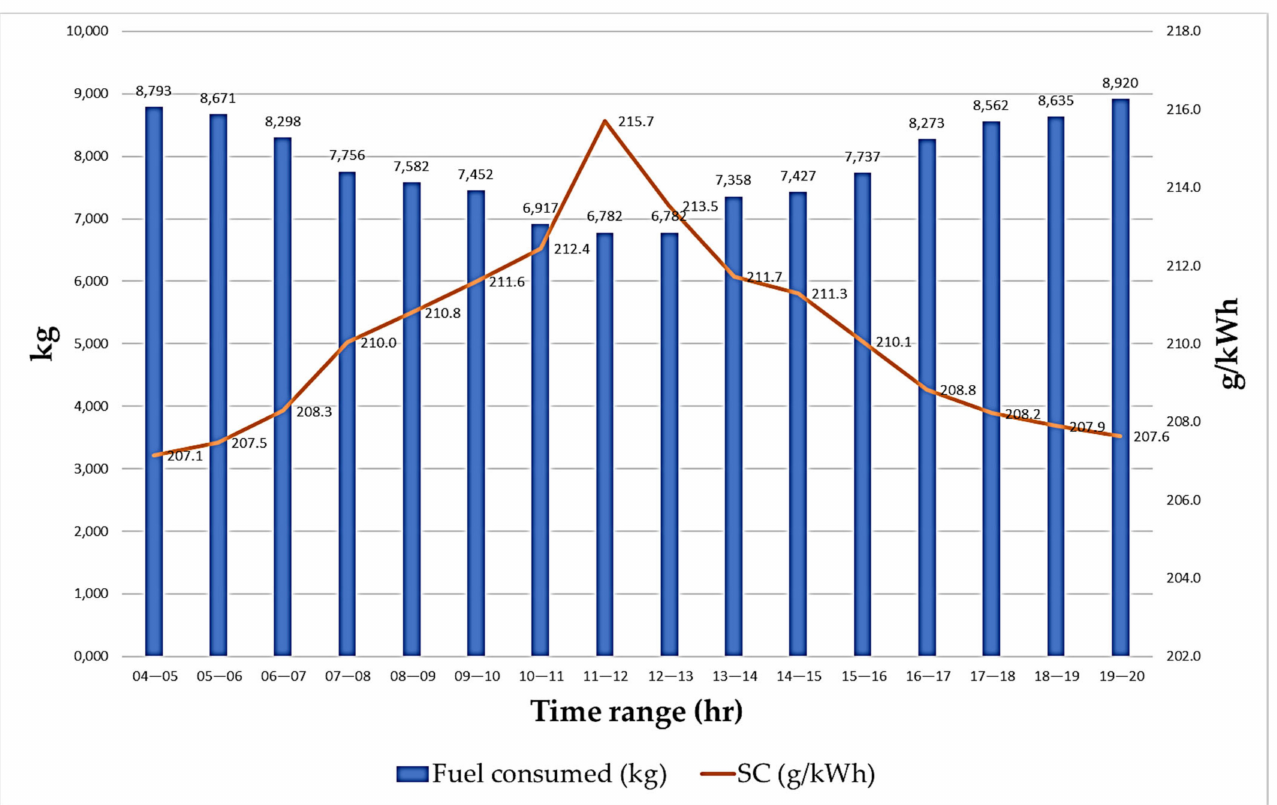
Figure 22. Fuel consumed (kg) and SC (g/kWh) of the thermal power plant (17 July